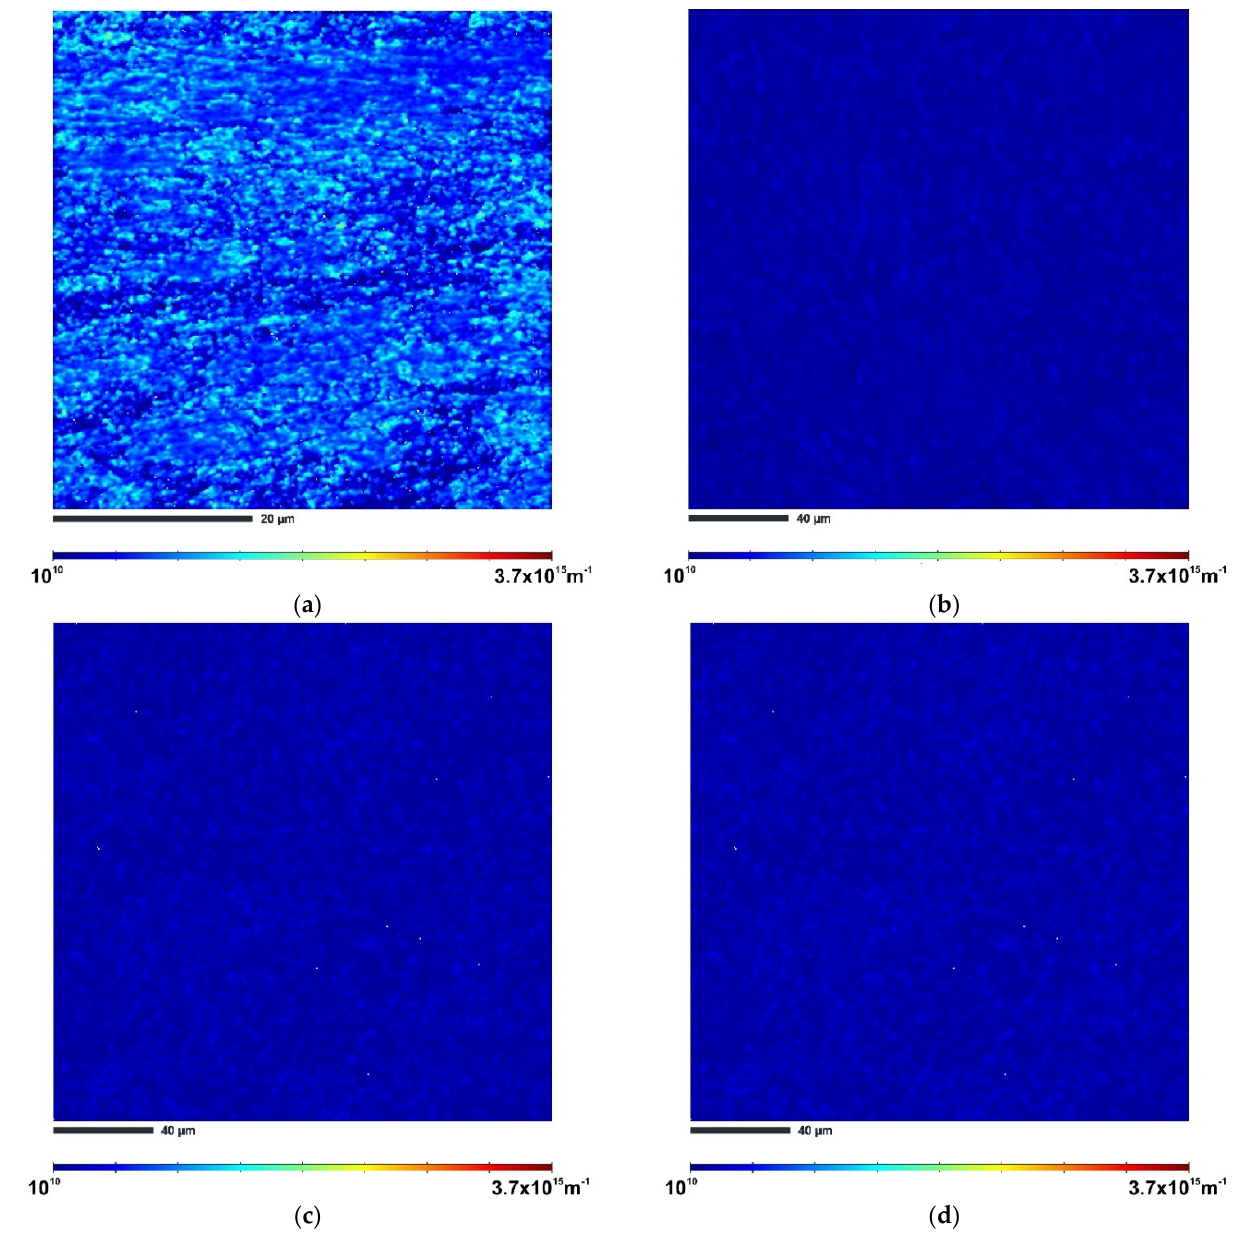
Figure 8. GNDs maps of ECAP ‐ processed samples ( a ) HT280E150; ( b ) SLME350; ( c ) SLME400; ( d ) SLME450.